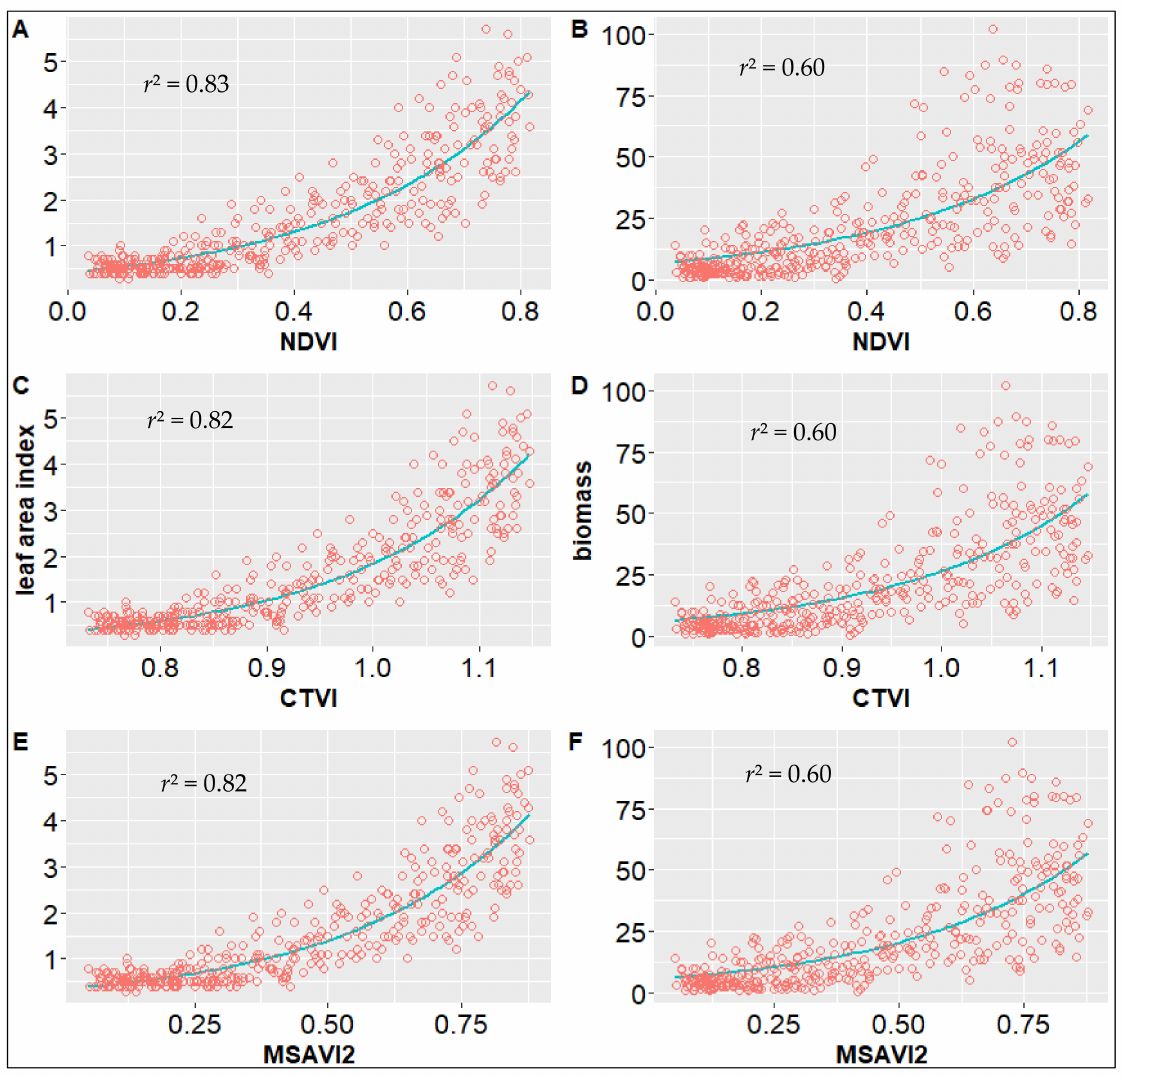
Figure 3. Calibration of LAI and biomass prediction models from vegetation indices using data from 2018 trial. Relationship between LAI and NDVI ( A ), CTVI ( C ), MSAVI2 ( E ); biomass and NDVI ( B ), CTVI ( D ), MSAVI2 ( F ). NDVI, CTVI and MSAVI2: vegetation indices; the green line in plots is the regression line; r 2 : coefficient of